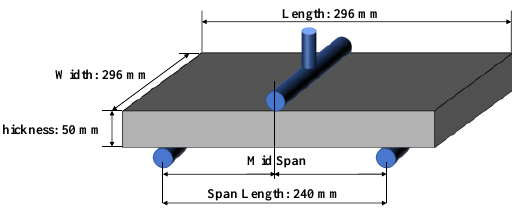
Figure 9. Test specimen configuration for the three-point bending test of the rubber beam.